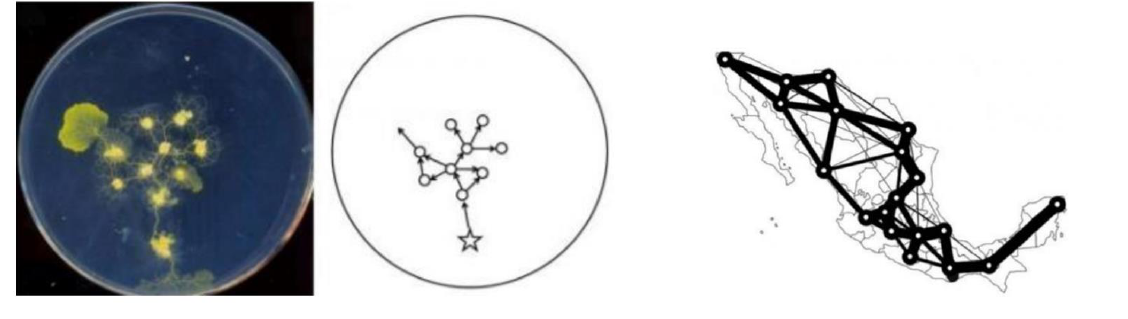
Figure 1: On the left: The behavior of Physarum Polycephal , on the right : The transport network in Mexico